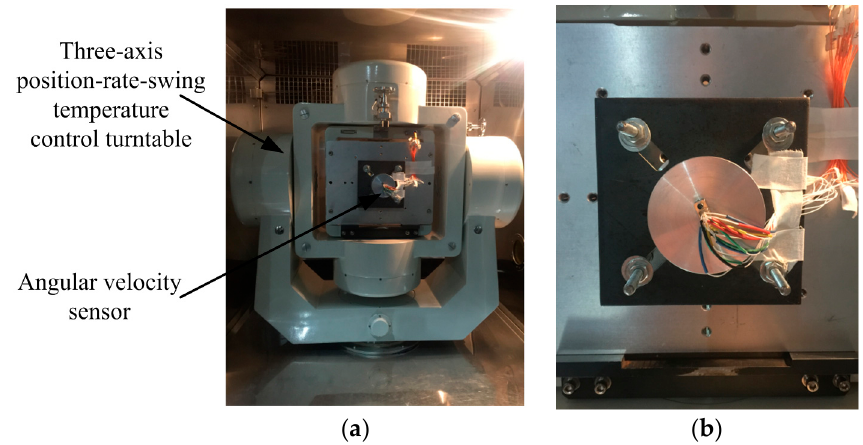
Figure 9. Experimental three-axis flight turntable test platform: ( a ) Three-axis turntable; ( b ) Fixed platform of the sensor.